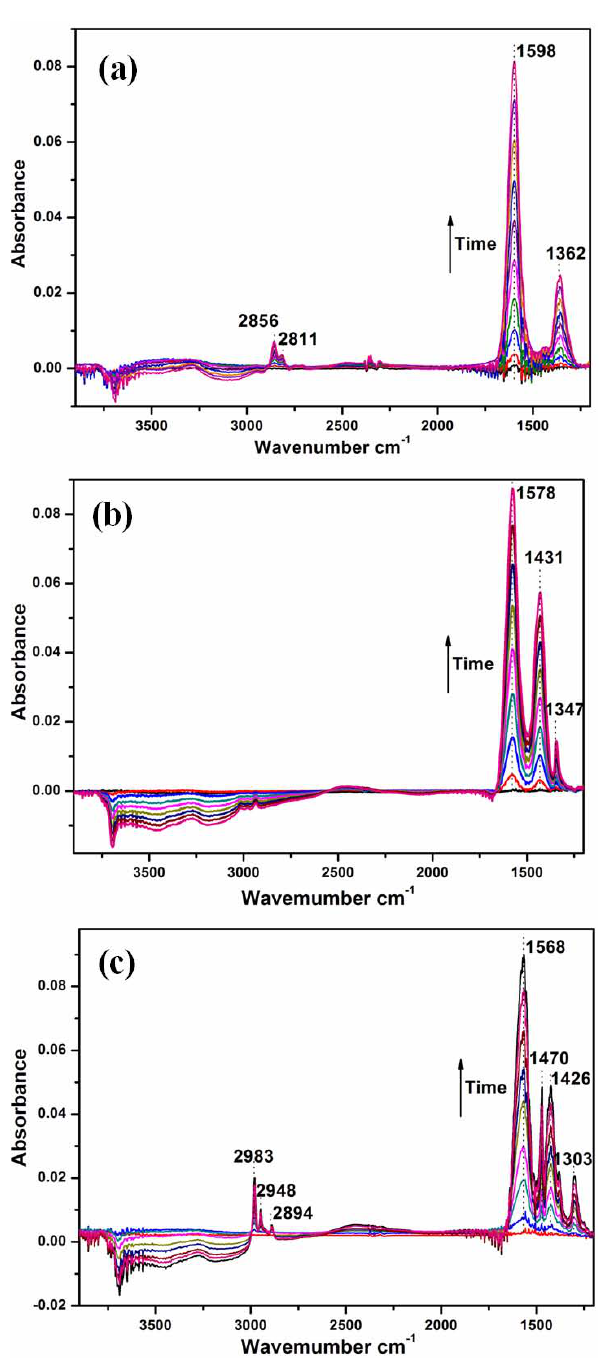
Fig. 6. Absorption spectra recorded during the reaction of (a) HCOOH, (b) CH 3 COOH and (c) CH 3 CH 2 COOH ([RCOOH] 0 =1.23 × 10 14 moleculescm − 3 ) on α –Al 2 O 3 particles at 30%